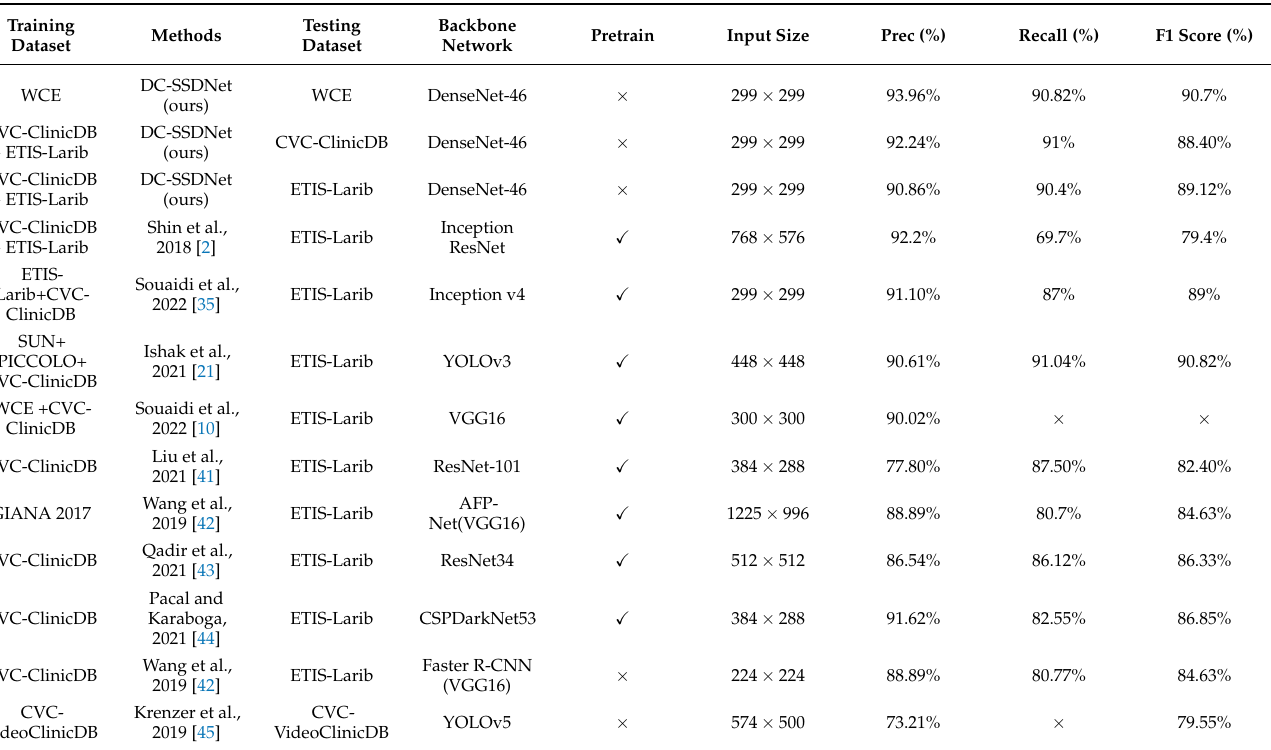
Table 6. Results of the WCE or the colonoscopy test with an IoU greater than 0.5 and a batch size of